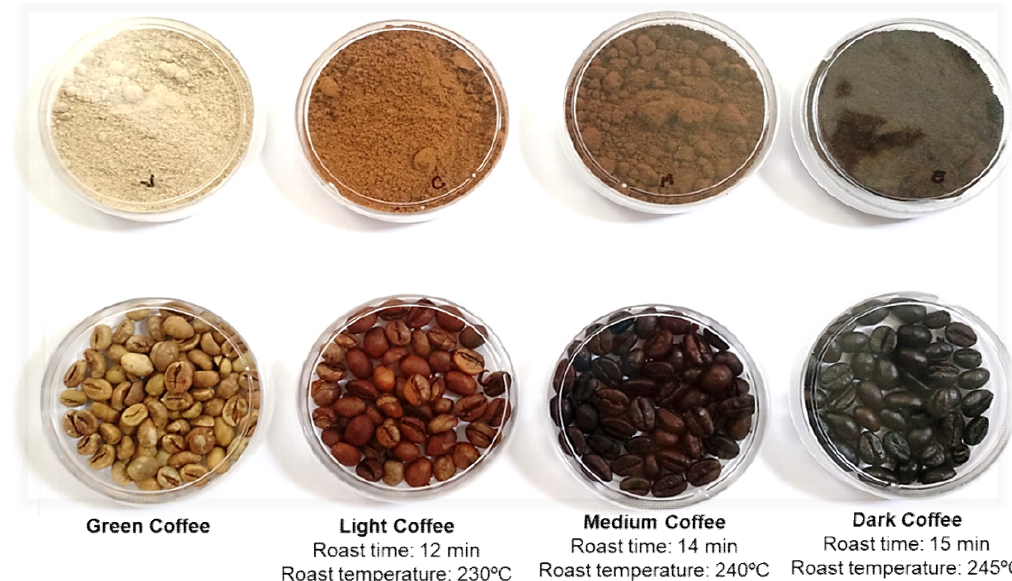
Figure 5. Beans and ground coffee (unroasted or with different levels of roasting).